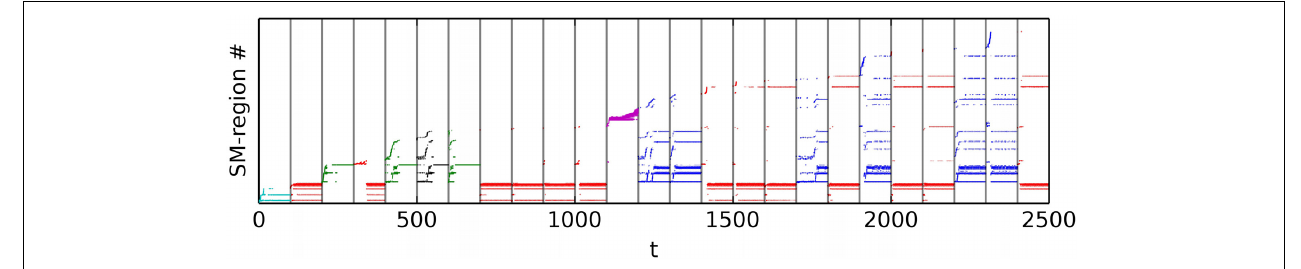
FIGURE 9 | Exploration and re-visitation of sensorimotor regions in habits that have emerged from a randomly initialized IDSM. To generate this alternative view of the sensorimotor trajectories displayed in Figure 8 , we subdivided the SM-space into a 10 × 10 × 10 × 10